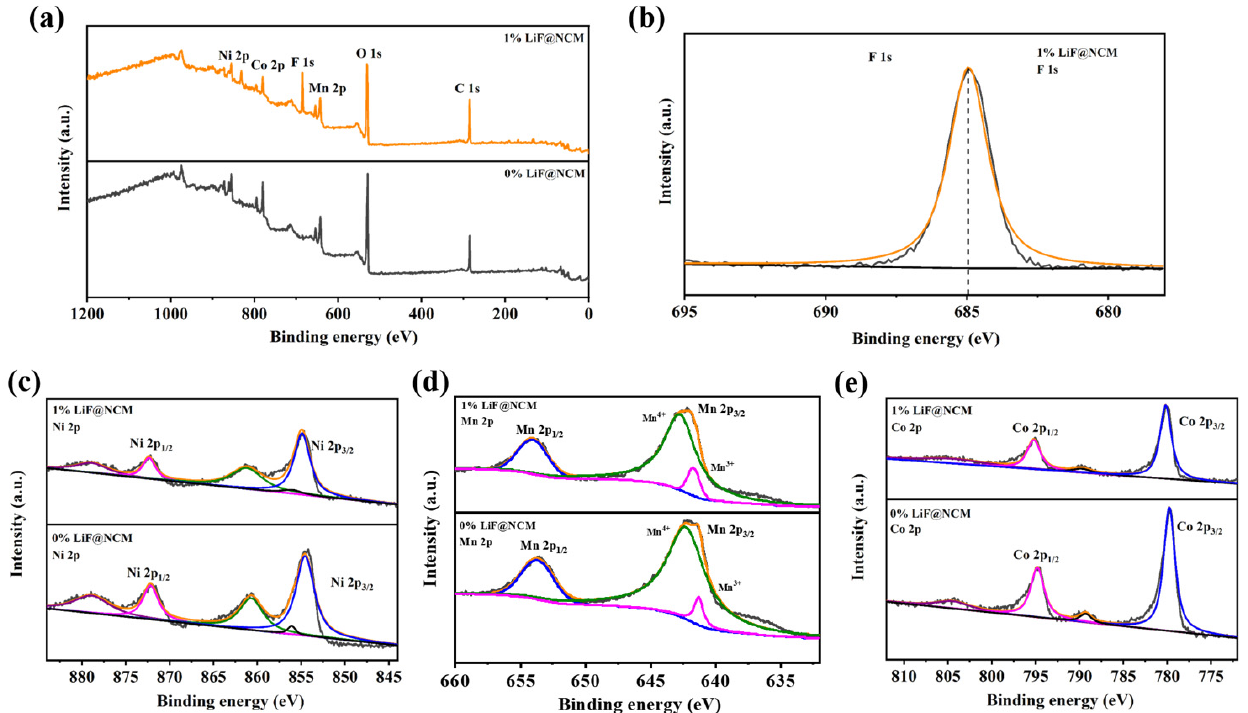
Figure 6. ( a ) XPS survey spectra of 0%LiF@NCM and 1%LiF@NCM; ( b ) F 1s XPS spectra of 1%LiF@NCM; ( c ) Ni 2p XPS spectra of 0%LiF@NCM and 1%LiF@NCM; ( d ) Mn 2p XPS spectra of 0%LiF@NCM and 1%LiF@NCM; ( e ) Co 2p XPS spectra of 0%LiF@NCM and